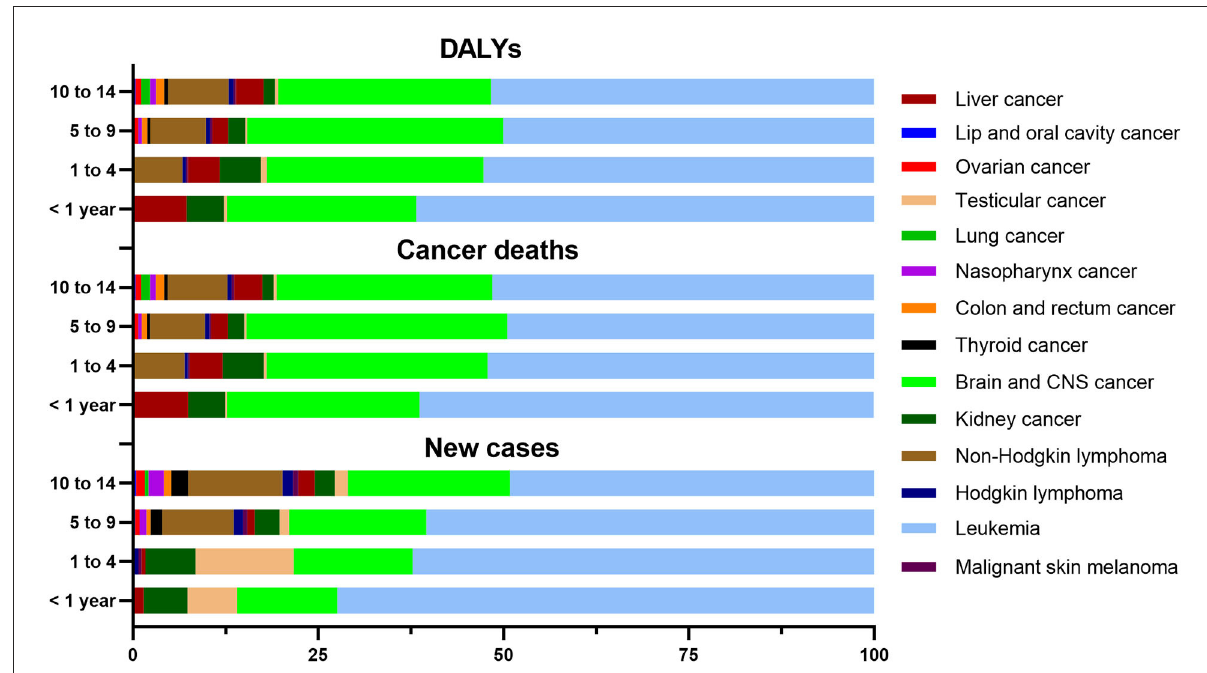
FIGURE3 Proportion of new cases, cancer deaths, and DALYs of childhood cancers in four age groups in China in